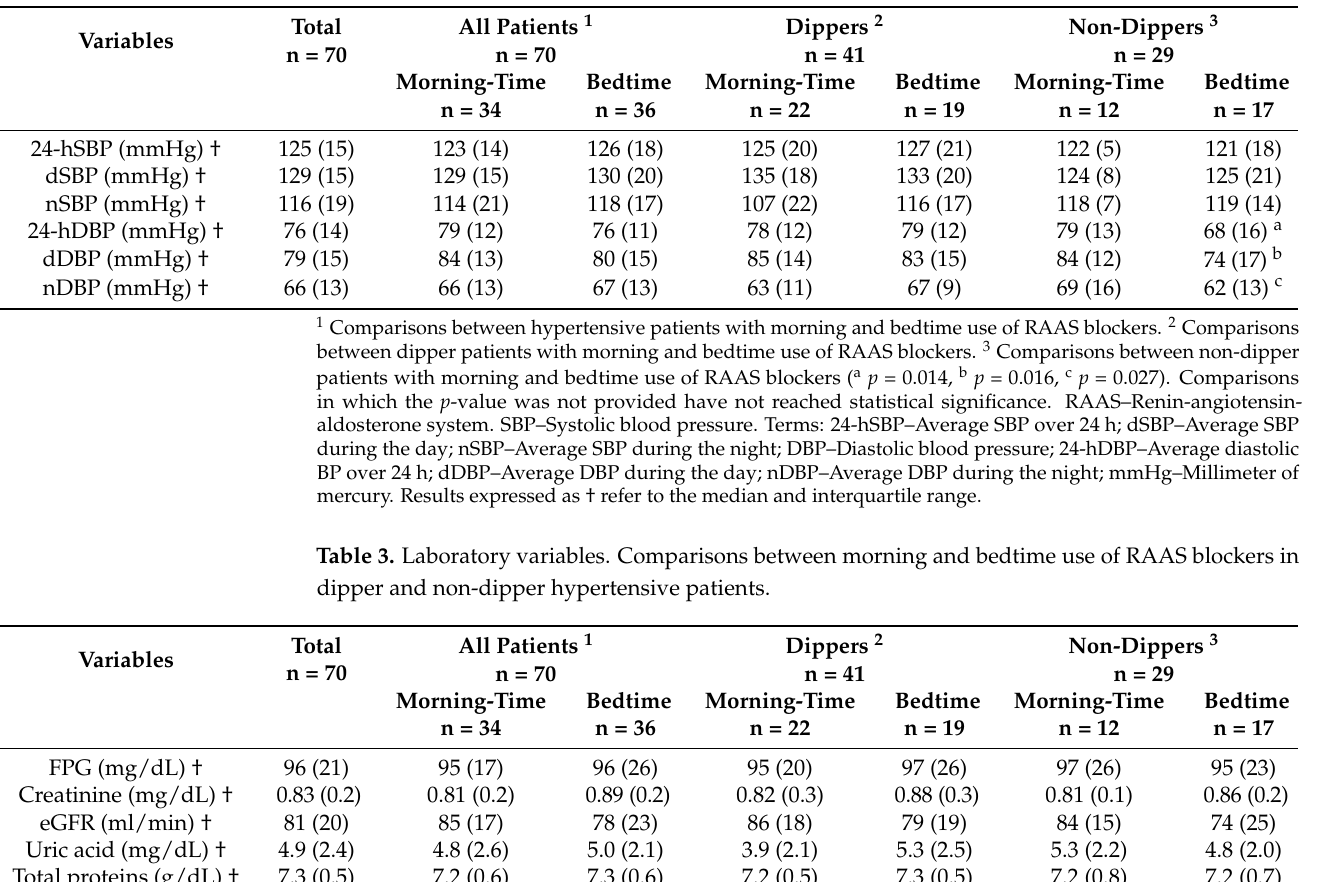
Table 2. Indices of twenty-four-hour ambulatory blood pressure monitoring. Comparisons between morning and bedtime use of RAAS blockers in dipper and non-dipper hypertensive patients.